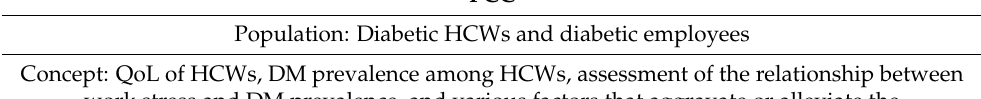
Table 1. PCC and Inclusion and Exclusion Criteria. PCC Population: Diabetic HCWs and diabetic employees